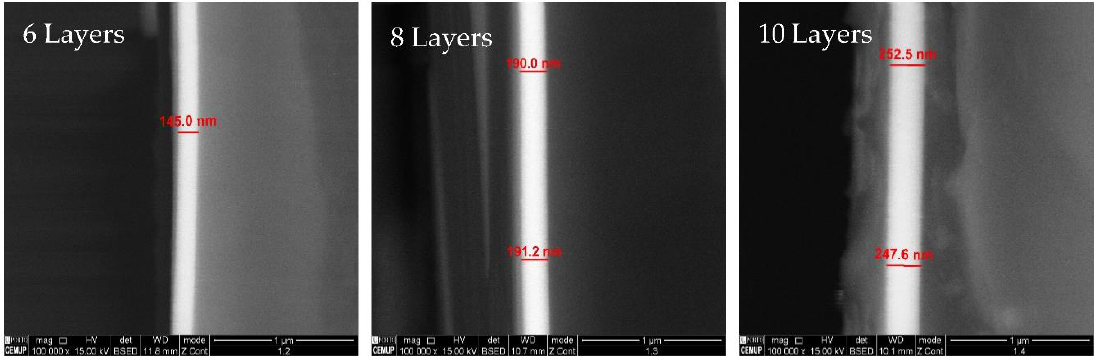
Figure 4. Cross-section view of the films obtained using 10 kW power in the samples with 6, 8, and 10 layers of chromium.